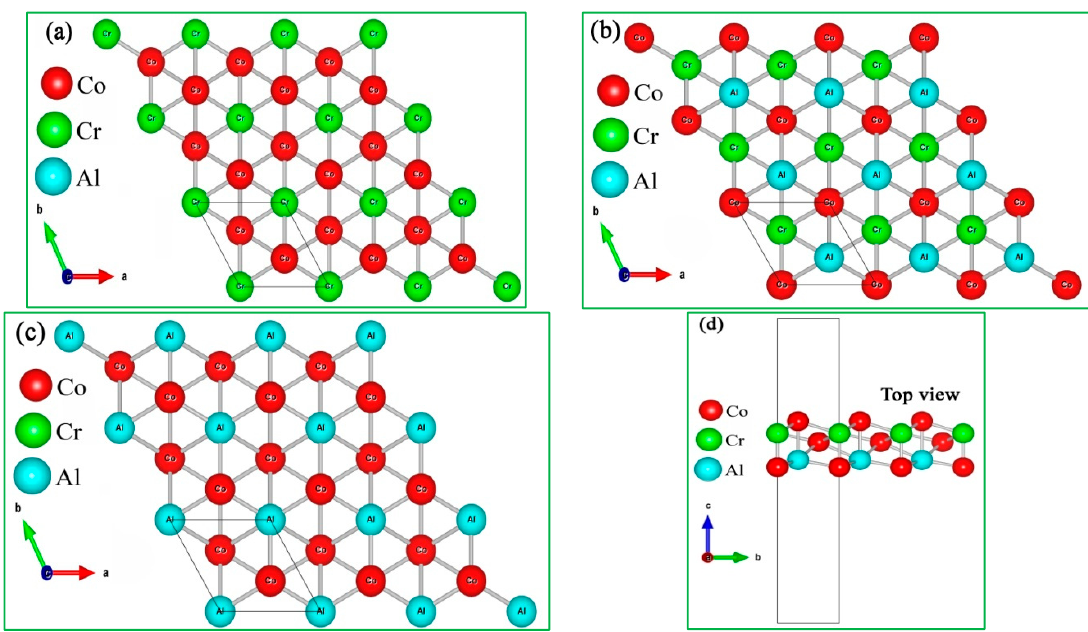
Figure 1. Crystal structure of the Co 2 CrAl compound from top and side view for: ( a ) α -, ( b ) β - and, ( c ) γ - phases ( d ) shows the thickness of the atomic layers from the side. Table 1. Structural and mechanical properties of Co 2 CrAl compound in the bulk and three Heuslerene phases, including: crystal lattice constants (a, c), formation energy (E for ), total magnetic moment (M tot ), partial magnetic moment (M p ), Bulk modulus (B), and derivative bulk modulus (B ’ ).